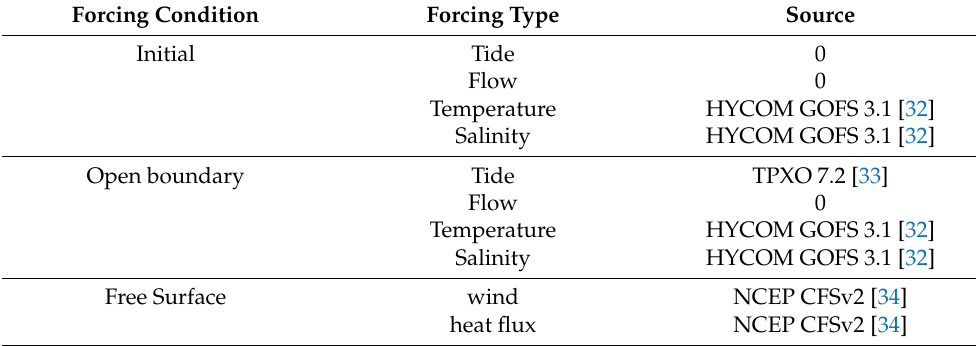
Table 1. Model forcing conditions and relevant